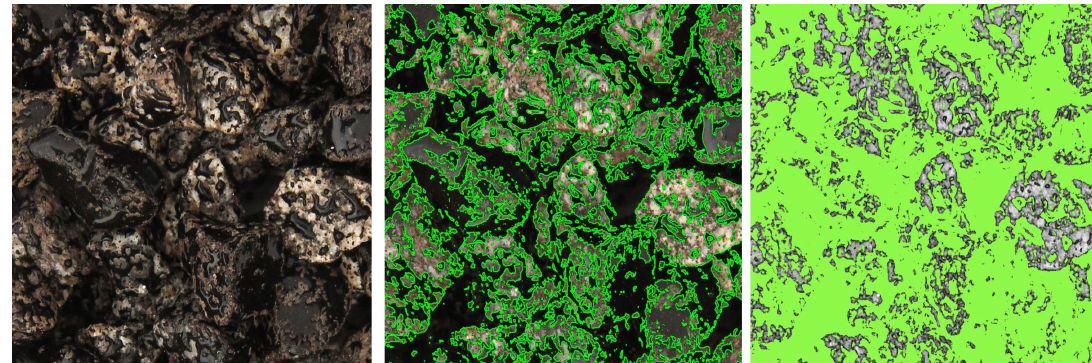
Figure 4. Images of aggregate Skuteč covered by reference binder, from left: original photo, gray level thresholding-, and entropy-based image